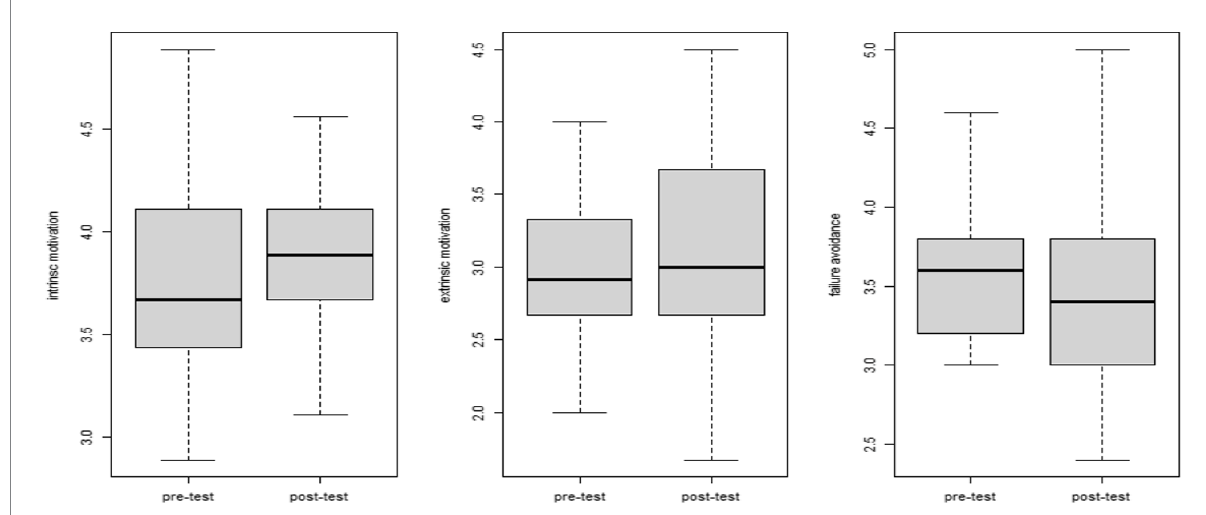
FIGURE 2 Differences in three research motivation categories between the pre-test and